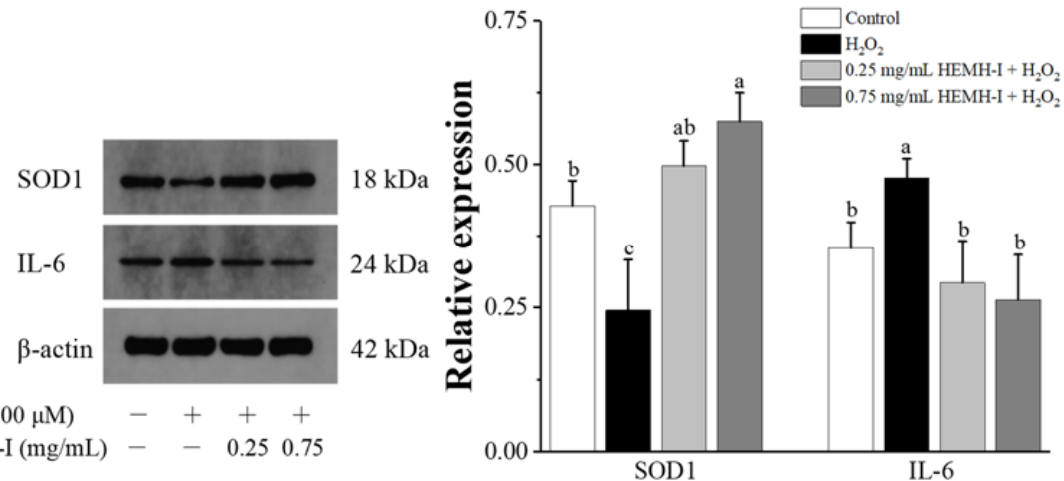
Figure 7. Effect of HEMH-I on expressing antioxidant enzyme SOD1 and inflammatory factor IL-6 in SW1353 chondrocytes. Values are expressed as mean ± SD ( n = 3). Means annotated with different letters (a–c) for the same parameter are significantly different ( p < 0.05).